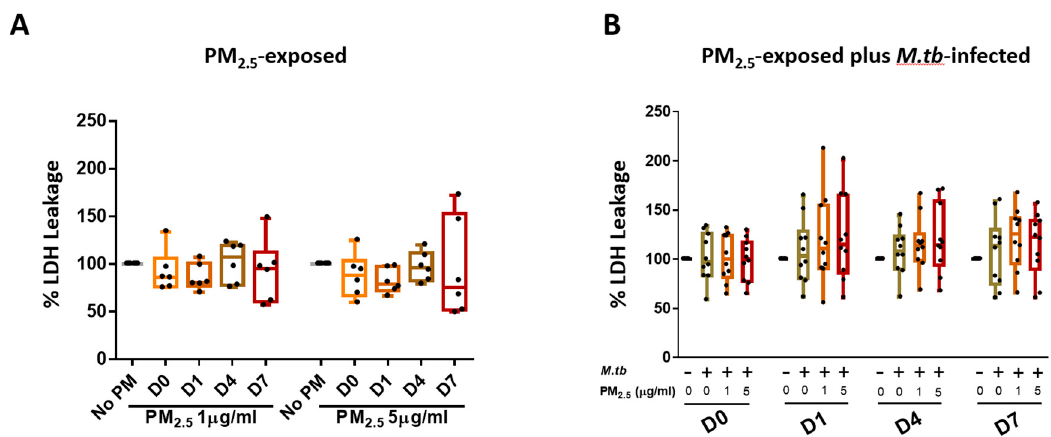
Figure 2. Cytotoxic effects of PM 2.5 in human peripheral blood mononuclear cells (PBMC). (A) PBMC from six study subjects were exposed to PM 2.5 at final concentrations of 0, 1, and 5 µg/ml for 0, 1, 4, and 7 days. As a measure of cytotoxicity, leakage of lactate dehydrogenase (LDH) into culture supernatants was determined. (B) Cytotoxic effects of PM 2.5 on PBMC from ten study subjects pre- exposed to PM 2.5 for 20 h followed by infection with M.tb at multiplicities of infection (MOI) 1 for 0